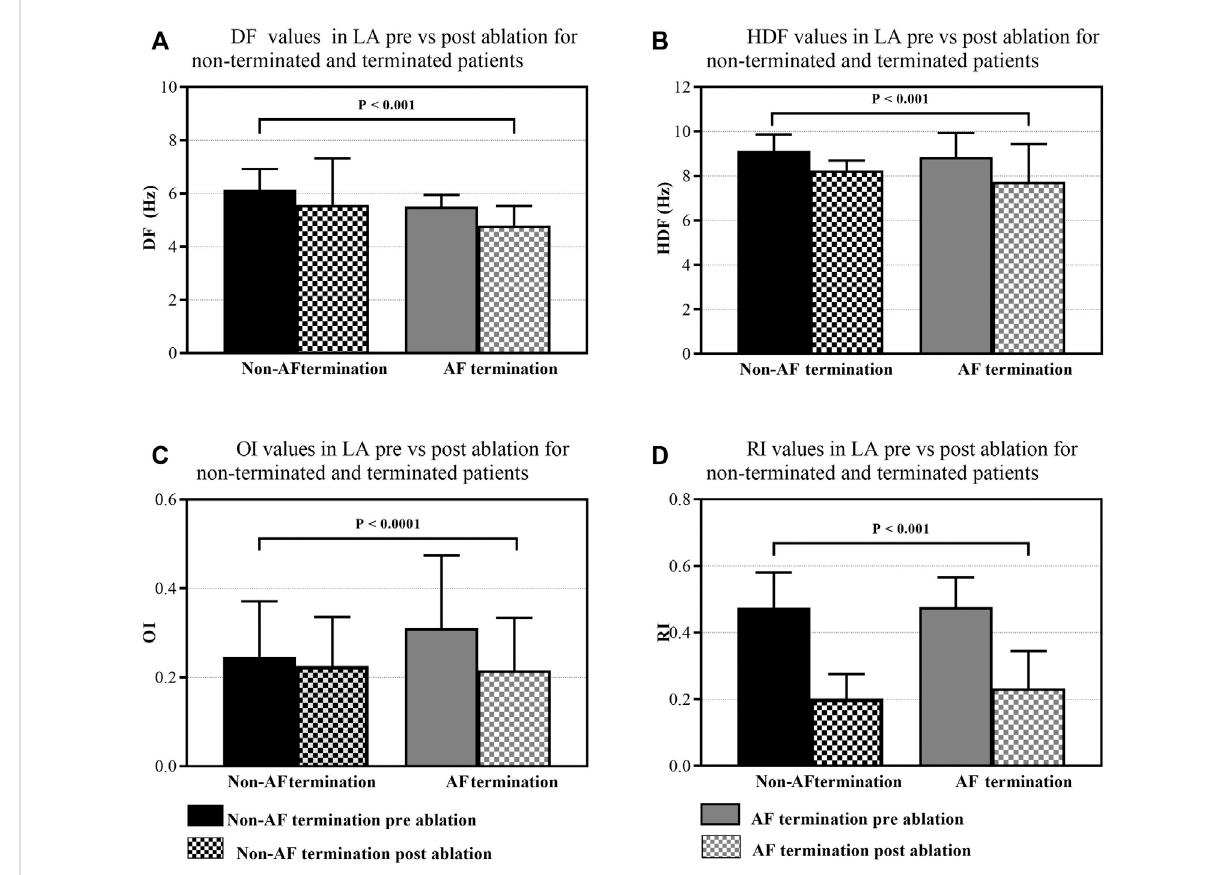
FIGURE 3 Monitoring the effect of HDF-guided ablation in PersAF patients. Bars represent the mean ± SD for each group. (A) DF across LA, pre-versus post-ablation for non-terminated and terminated patients. (B) HDF values change across LA, pre-versus post-ablation for non-terminated and terminated patients. (C) OI values change across LA, pre-versus post-ablation for non-terminated and terminated patients. (D) RI values change across LA, pre-versus post-ablation for non-terminated and terminated